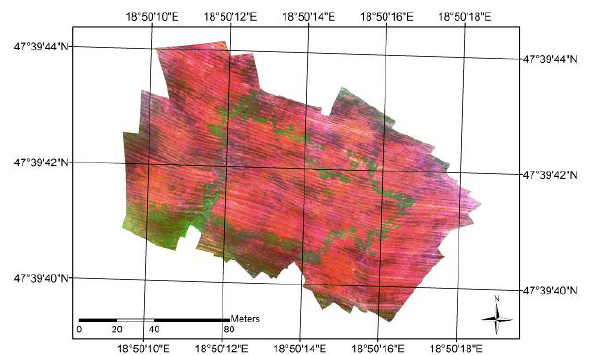
Figure 7. The false-colour mosaic of the crop-mark Green: plants of the crop-mark; Red: grass and